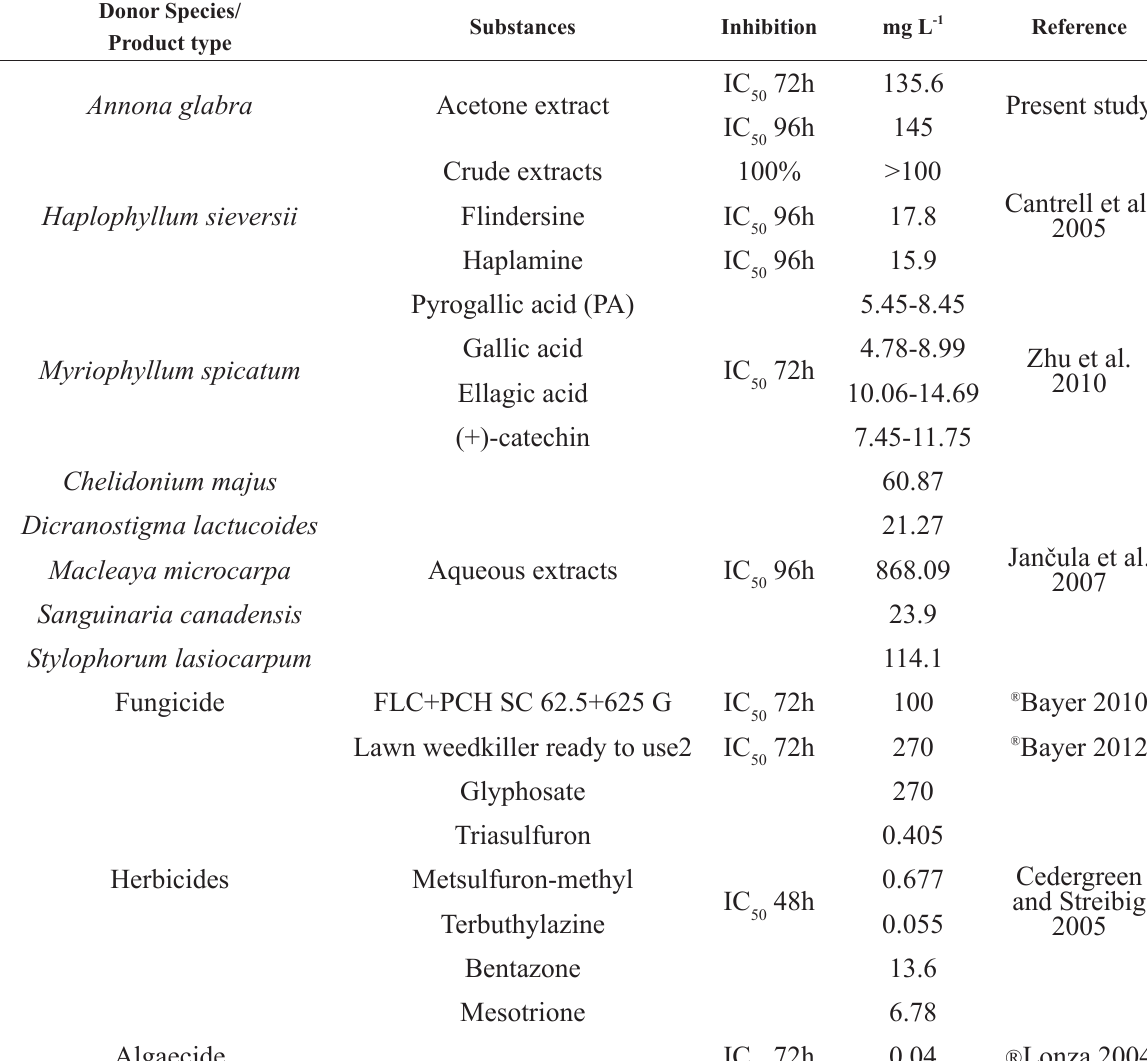
) of extracts and compounds on Raphidocelis subcapitata 50 Korshikov in toxicity